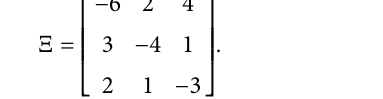
( t ) − x ( t )| 2 of Example i 1